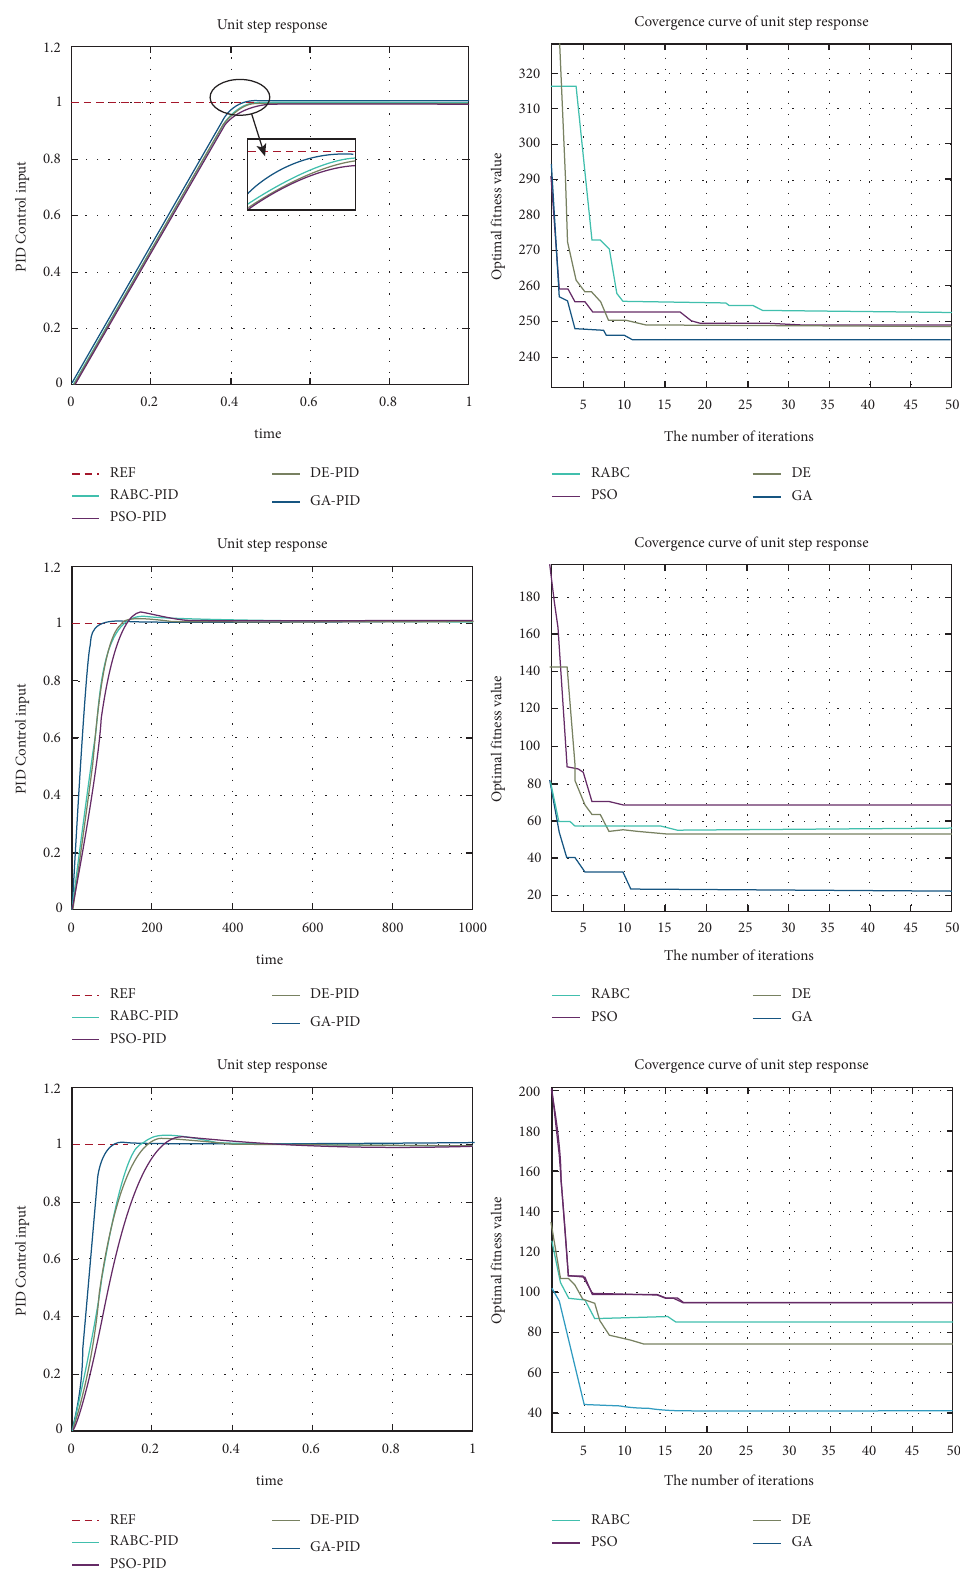
Figure 10: Unit step response curve and convergence curve when the parameters T � 20, T